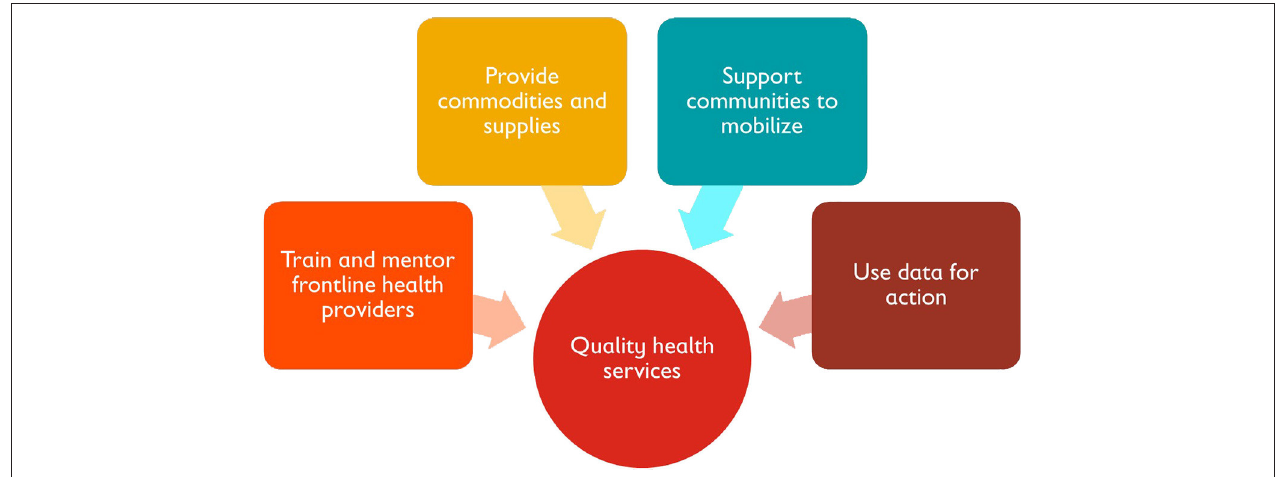
FIGURE 1 | Save the Children’s approach to ensure voluntary, high-quality FP, and PAC services in humanitarian settings.